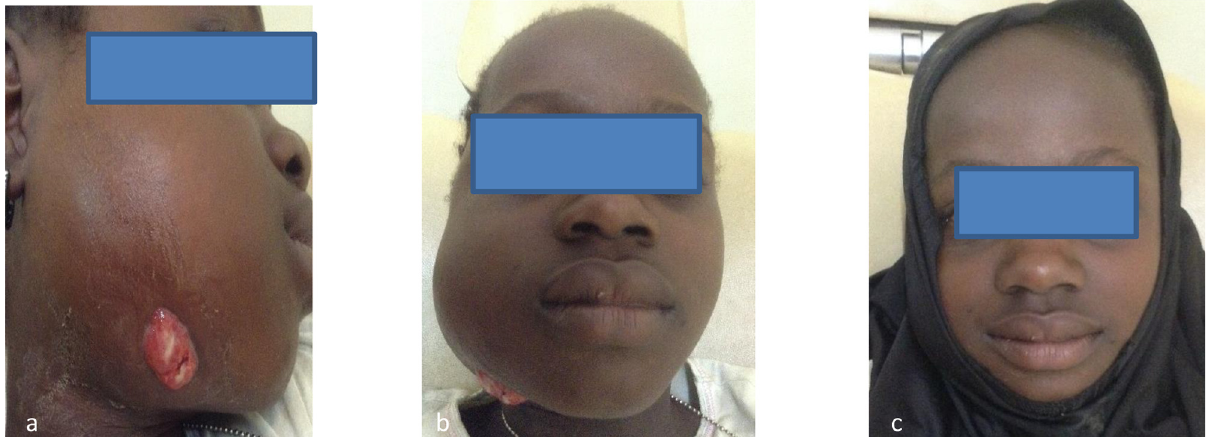
Fig. 1. Diffuse odontogenic mandibular osteitis fi stulized below the chin (a). Frontal view of the voluminous swelling (b) and concealment of the swelling (c).